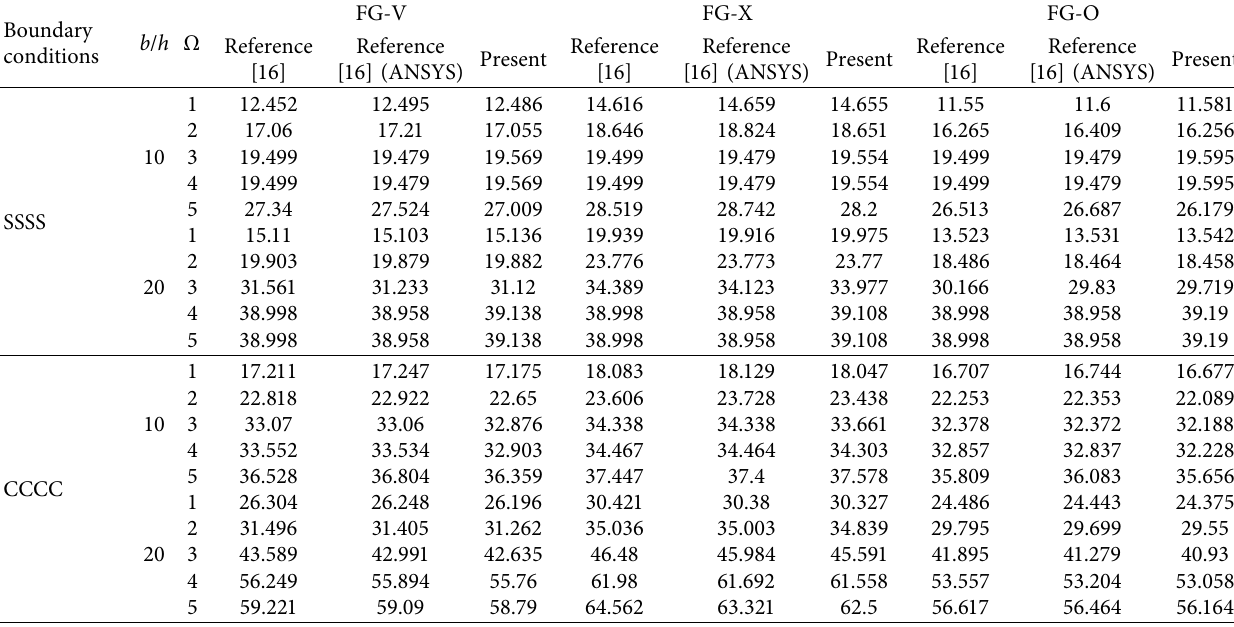
Table 5: Comparison of dimensionless frequency of non-stepped FG-CNTRC plate.